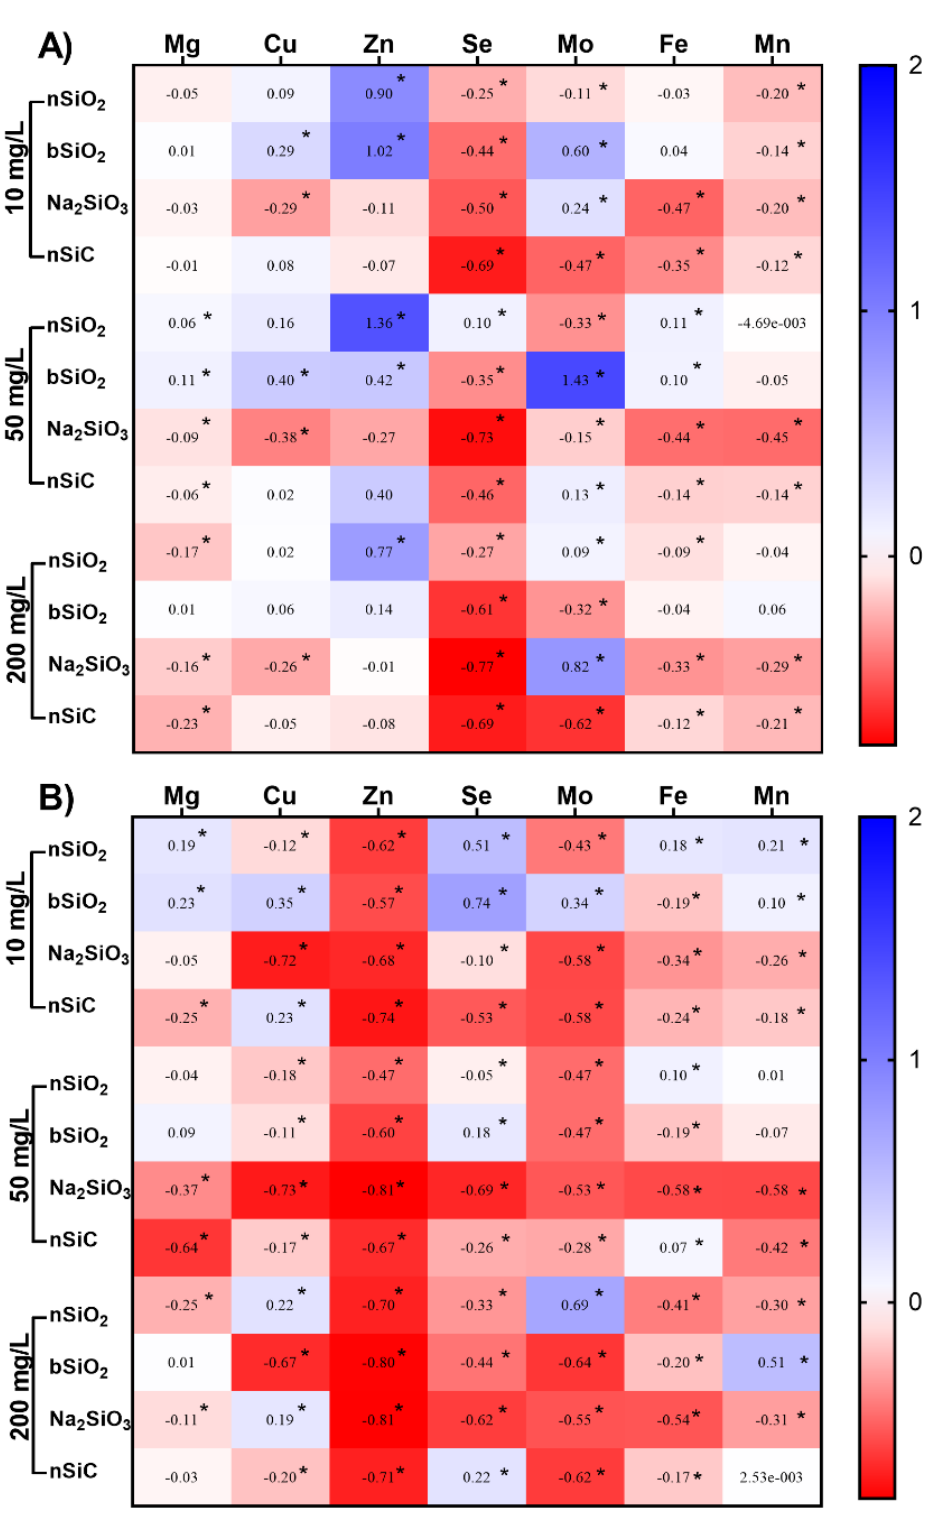
Figure 5. The heat map reflects the percentage increase or decrease of mineral element content in Si-based NMs treated rice (the shoot is ( A ) and root is ( B )) compared to the control (CK) group. * Indicates significant difference compared to CK group at p < 0.05.